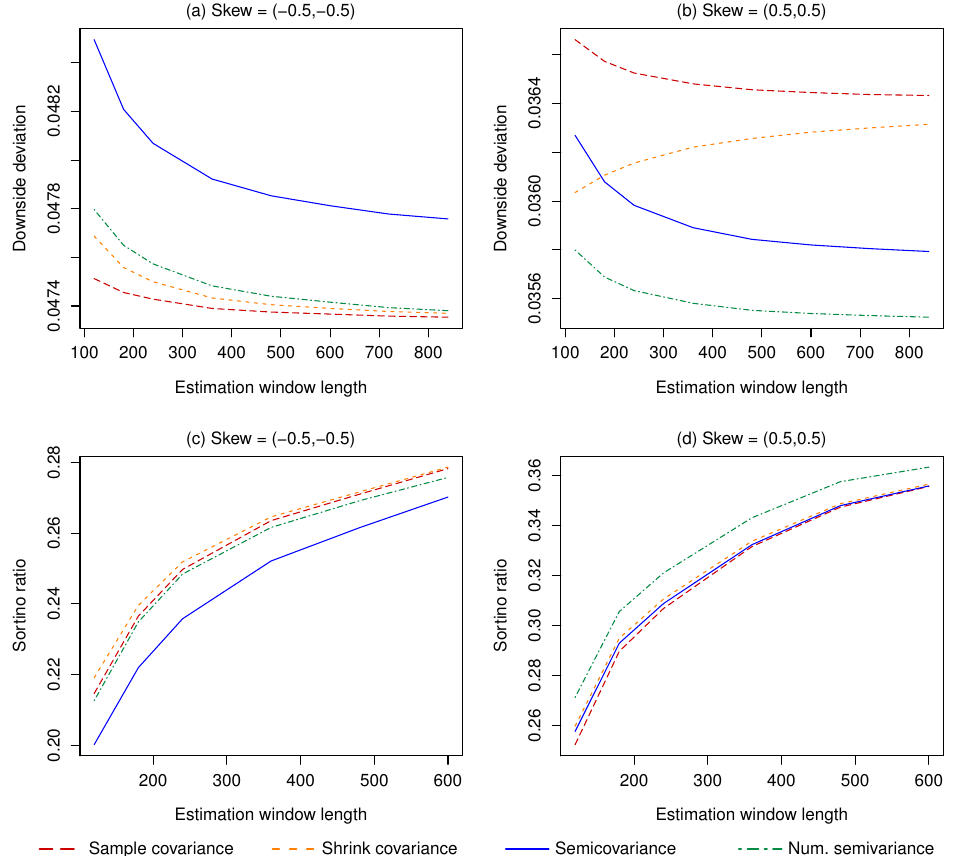
Figure 6. Portfolio performance with asset returns generated from a multivariate skew normal distribution. ( a ) Minimum variance/semivariance portfolios with negatively skewed asset returns; ( b ) Minimum variance/semivariance portfolios with positively skewed asset returns; ( c ) Mean-variance/semivariance portfolios with negatively skewed asset returns; ( d ) Mean-variance/semivariance portfolios with positively skewed asset